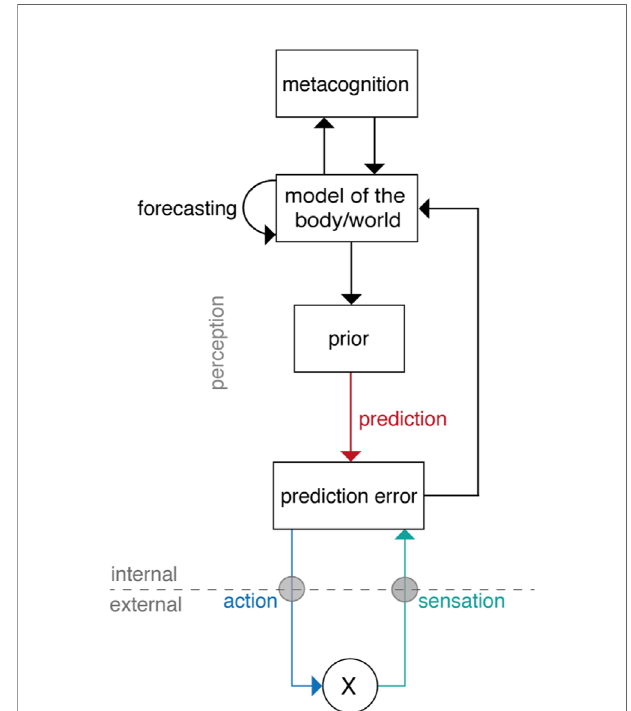
FIGURE 3 | A general scheme of “ Bayesian brain ” theories of cognition. Here, the overall goal is to minimize prediction errors. Prediction errors represent, simply speaking, the difference between actual sensory input (or sensation, green arrow) and a prediction about the input which originates from a prior belief (red arrow). Minimization of the prediction error can either be achieved by updating the brain ’ s model (perceptual inference, e.g., according to predictive coding; middle part of fi gure) or by choosing actions such that beliefs are ful fi lled, and the predicted sensory inputs occur (active inference; lower part of fi gure). In addition to inference and action, hierarchical Bayesian models also allow for forecasting future states and offer an opportunity to integrate metacognition as a top-level that monitors levels of prediction errors (upper part of fi gure). Reprinted from Petzschner et al. (25), with permission from